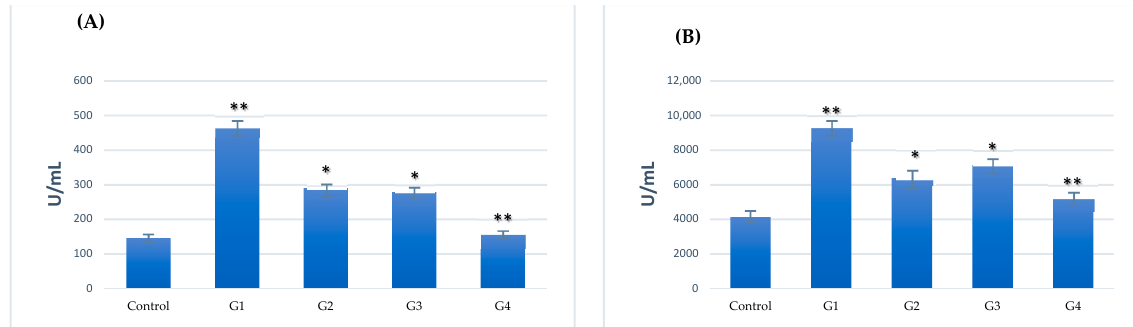
Figure 3. ( A ) Superoxide dismutase (SOD) activity after Gallium-68 injection with and without protective treatment with Angelica archangelica and Ginkgo biloba ; ( B ) glutathione peroxidase (GPX) activity after Gallium-68 injection with and without protective treatment with Angelica archangelica and Ginkgo biloba . * Significant p < 0.05 and ** highly significant p < 0.01.